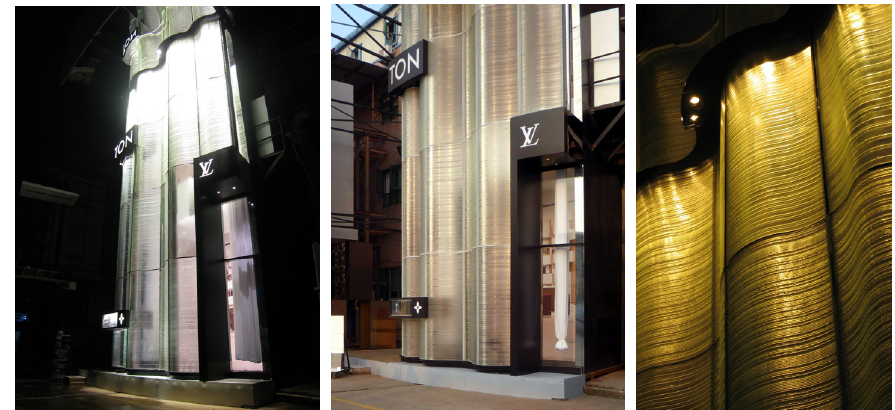
Figure 23a, b, c: Full Scale Prototype Night, Full Scale Prototype Day, Detail